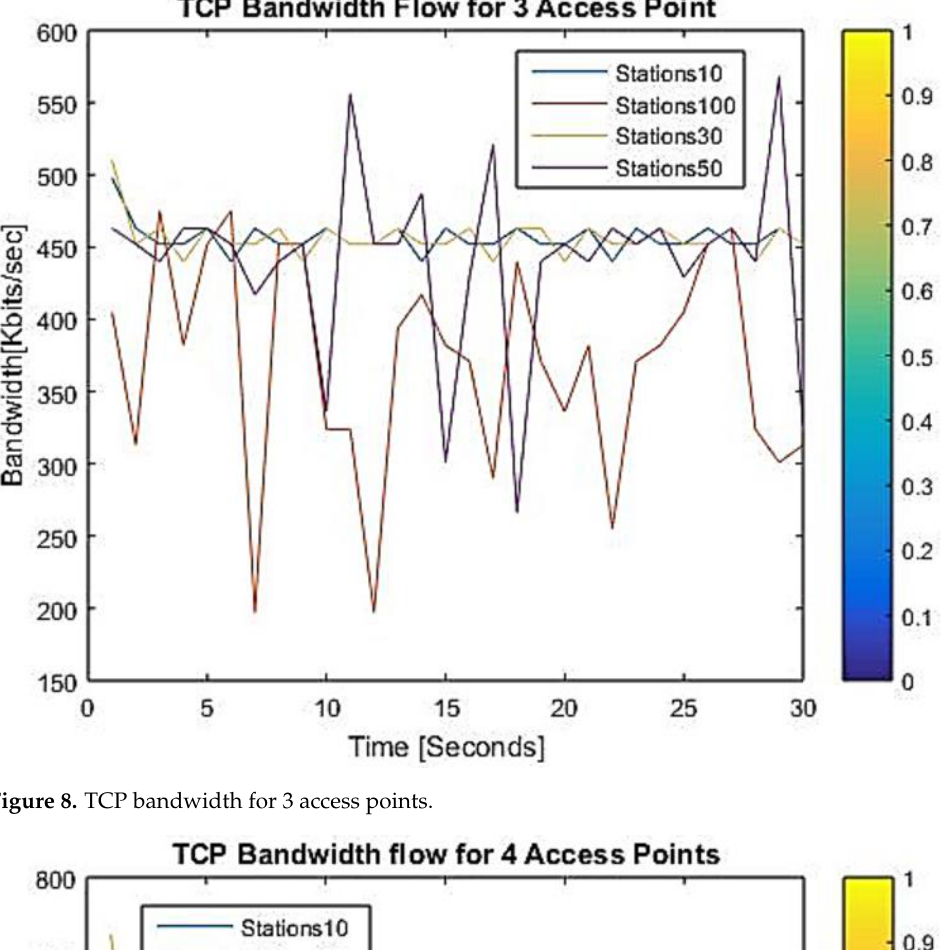
Figure 8. TCP bandwidth for 3 access points.